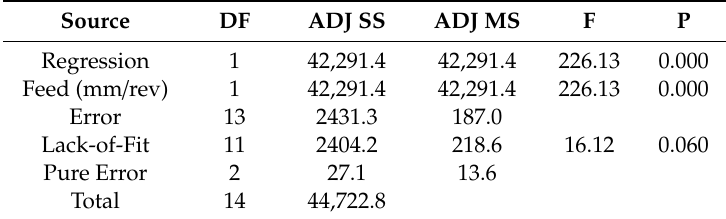
Table 8. ANOVA for with stepwise regression of alpha 0.1.